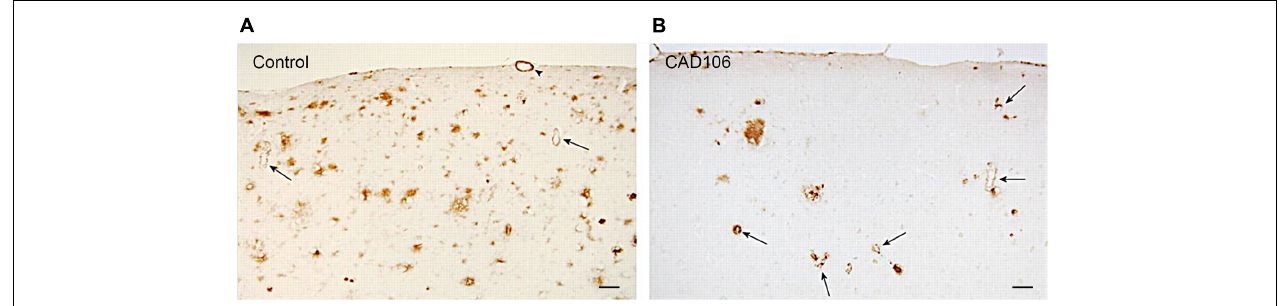
FIGURE 2 | A β deposition in the neocortex of APP24 mice after (A) PBS or (B) CAD106 treatment. Reduction of plaques and worsening of CAA is seen after immunisation (arrows). Scale bar = 100 µ m. Reproduced with permission from Wiessner et al.